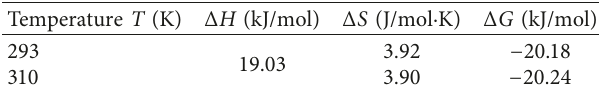
Table 3: Thermodynamic parameters of reaction system of hPPAR c protein and